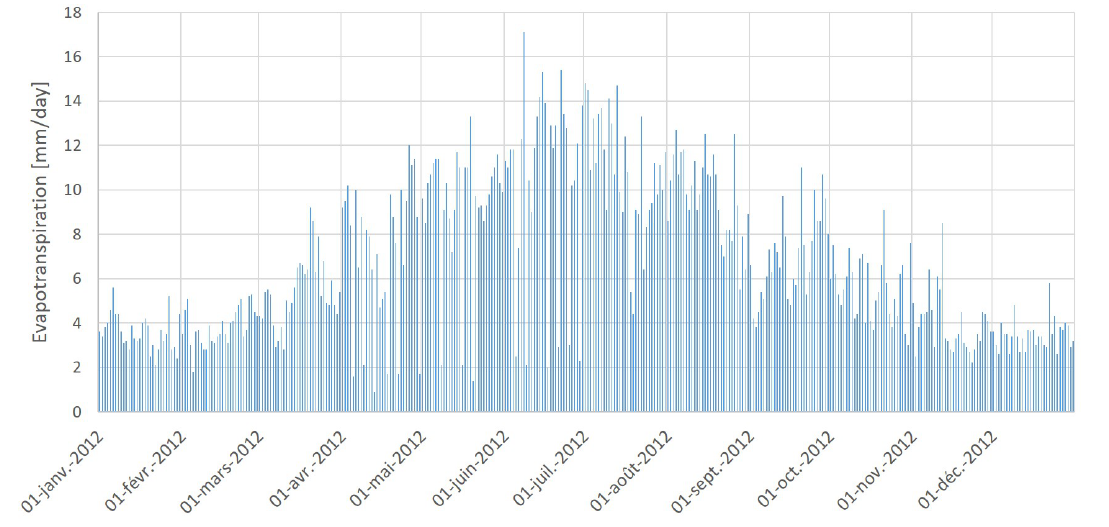
Figure 5. Daily evapotranspiration (mm/day) during 2012 calculated with ET0